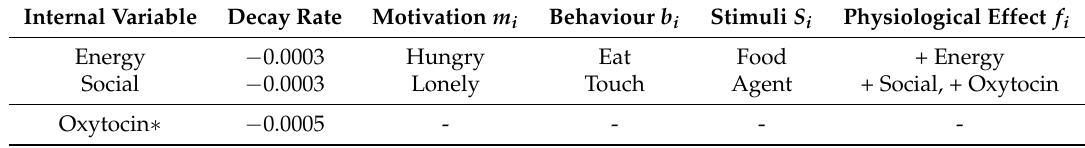
Table 2. Rate of change, per time step, of each internal variable for each agent. Please note that oxytocin ( OT ) is included in this table, but is defined as a modulating hormone, not as an internal variable that needs to be homeostatically